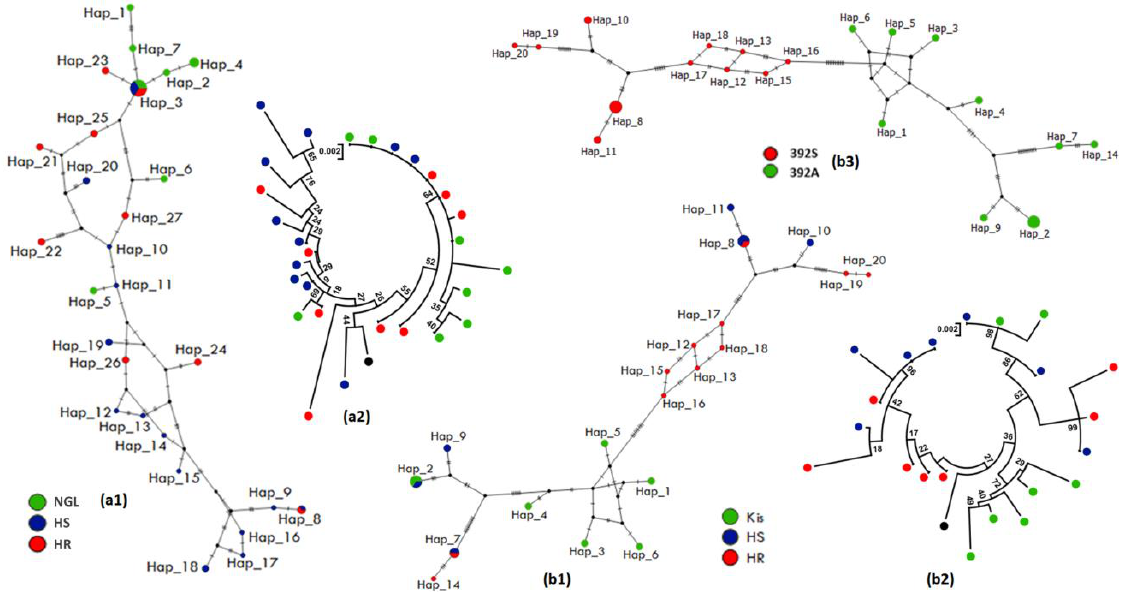
Figure 4. Pattern of the genetic variability and polymorphism of full-gene length of CYP6M2 . ( a1 ) TCS-network of the An. coluzzii sequences showing haplotypes and their respective frequencies (Hap_3, inset); ( a2 ) a maximum likelihood phylogenetic tree of An. coluzzii sequences generated using Tamura 3-parameter model; ( b1 ) TCS-network of the An. gambiae sequences showing haplo-